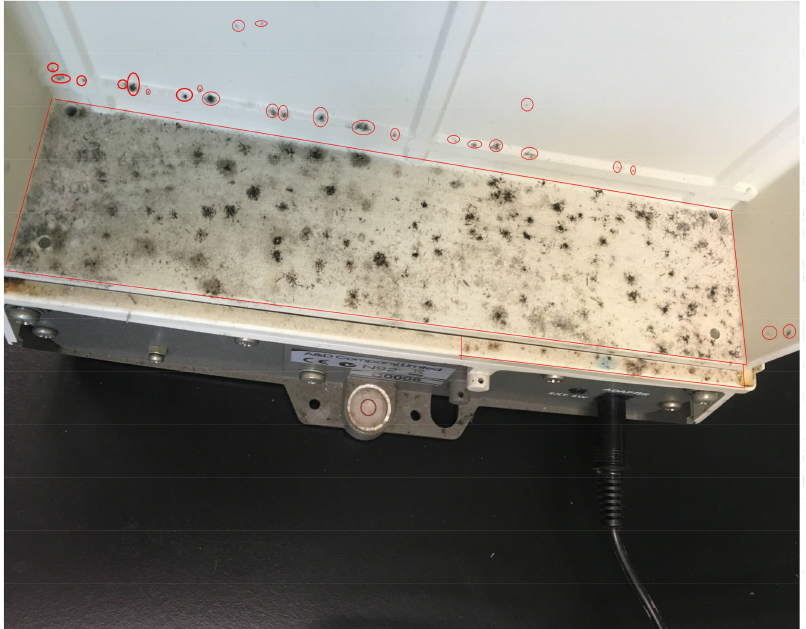
Figure 1. Mold patches behind an analytical balance (M008). The red circles indicate individual mold colonies. The red rectangular area represents one mold patch area because individual colonies are numerous and cannot be